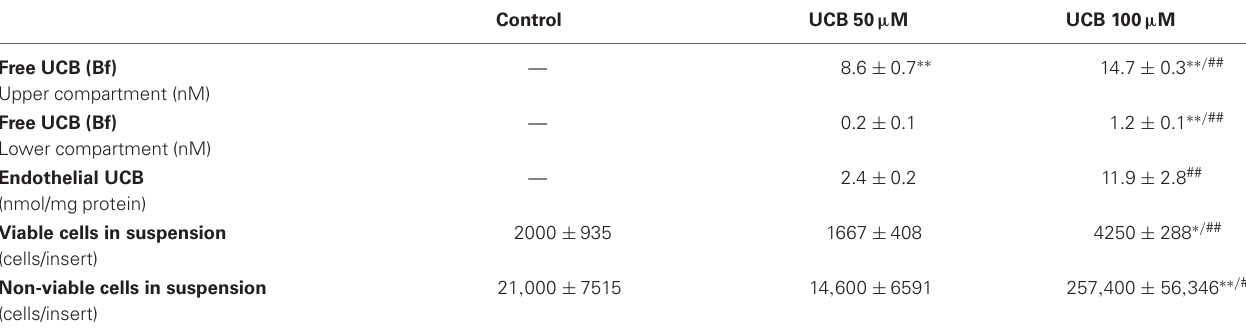
Table 1 | Distribution of UCB across the HBMEC monolayer and consequent damage after 72h of incubation.